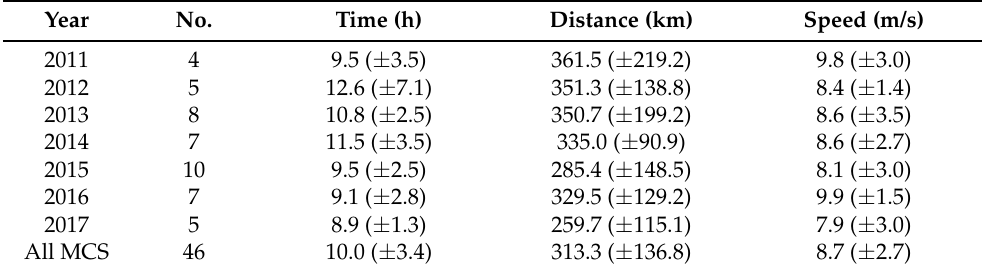
Table 4. Propagation speed estimation for MCS trajectory 2 and propagating northward. Means and ± one standard deviation (